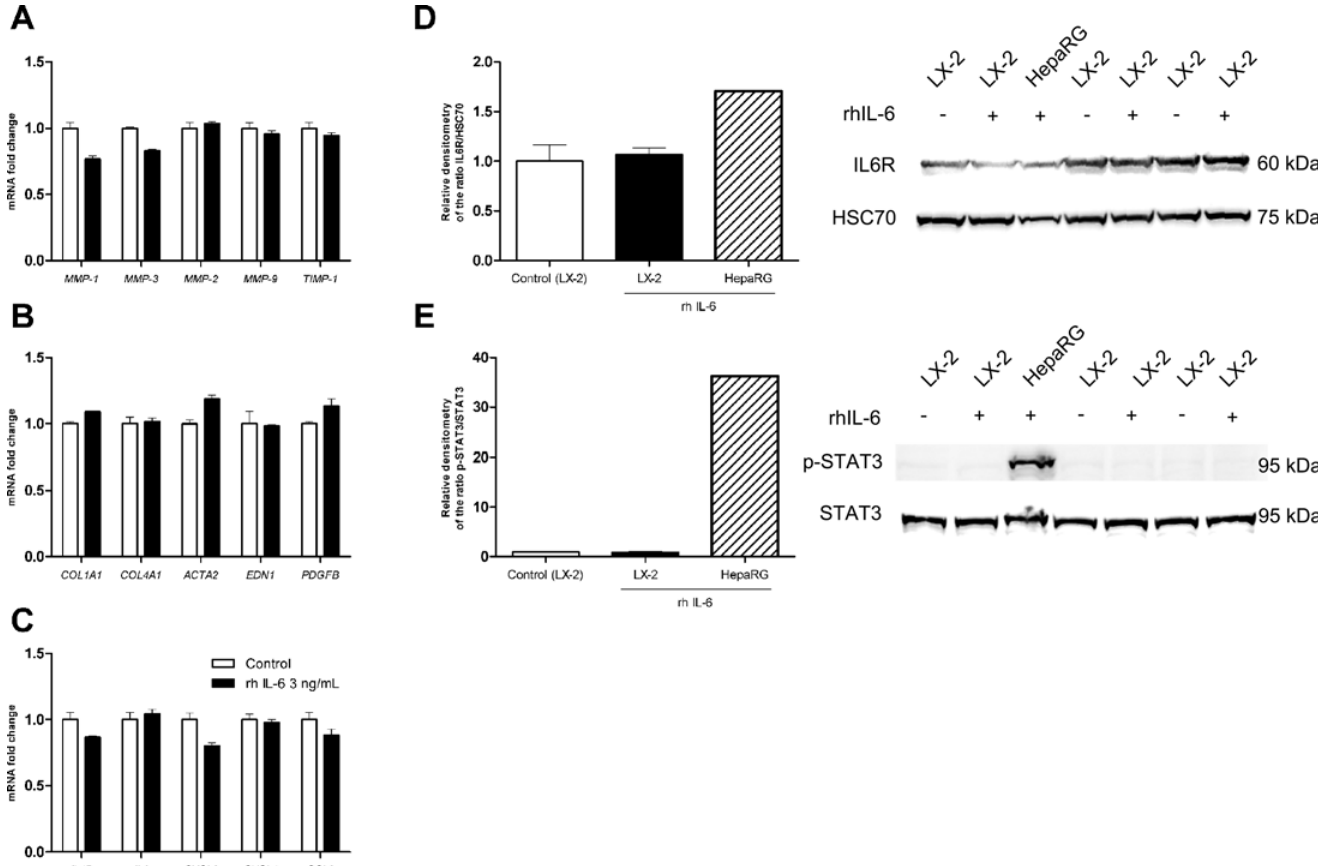
Fig 2. Effects of IL-6 treatment on the fibrolysis balance, fibrotic response and inflammatory response in LX-2 cells. The cells were treated with at 3 ng/mL rhIL-6 for 30 minutes or 24 hours. (A) mRNA expression of metalloproteinases (MMP-1, MMP-3, MMP-2, MMP-9) and tissue inhibitor of metalloproteinases (TIMP-1), as measured with real-time PCR and normalized against that of GAPDH after 24 hours of treatment. (B) mRNA expression of fibrogenesis factors (COL1A1/collagen I α 1, COL4A1/collagen IV α 1), myofibroblast differentiation factors (ACTA2/ α -smooth muscle actin) and myofibroblast activation factors (EDN1/endothelin-1, PDGFB/platelet-derived growth factor-BB), as measured with real-time PCR and normalized against that of GAPDH after 24 hours of treatment. (C) mRNA expression of proinflammatory cytokines (IL1B/interleukin-1 β , IL6/interleukin-6) and chemokines (CXCL8/interleukin- 8, CXCL1/GRO α , CCL2/MCP1), as measured with real-time PCR and normalized against that of GAPDH after 24 hours of treatment. (D) IL6R protein expression was determined by western blot on HepaRG and LX-2 cells lysates after 24 hours treatment and relative quantification was evaluated using densitometry. (E) p-STAT3 protein expression was determined by western blot on HepaRG (positive control) and LX-2 cells lysates after 24 hours treatment and relative quantification was evaluated using densitometry. Results are expressed as the mean ± SEM of three independent